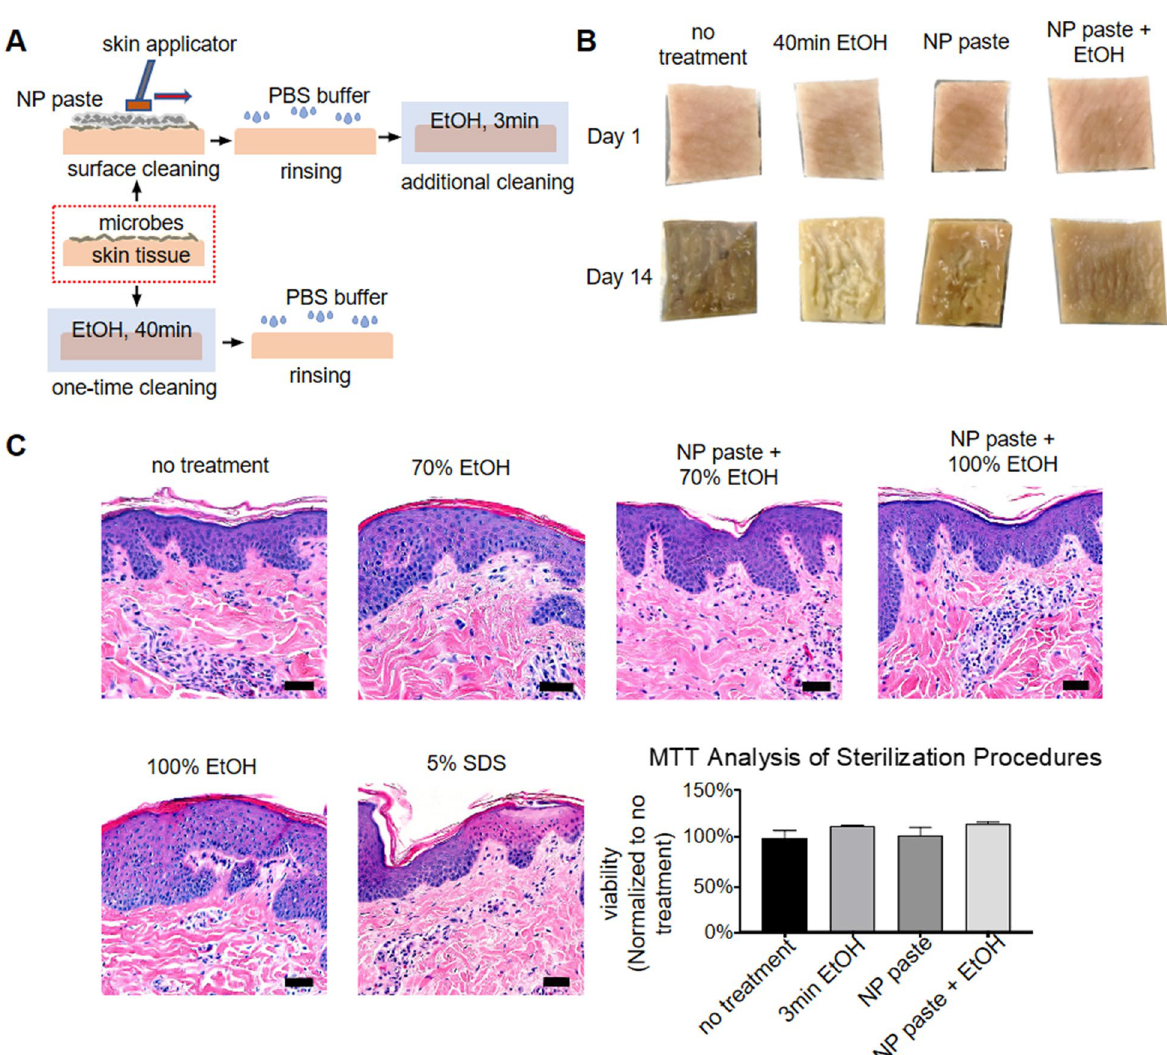
Figure 2. Porcine skin preparation process. ( A ) NP paste was applied to the skin surface and spread by moving an applicator gently back and forth for 5 min followed by sequential rinsing in PBS, 3 min incubation in 70% or 100% EtOH, and a final rinse in PBS. ( B ) Photographic images of skin at Day one and Day 14 after preparation. ( C ) Skin irritation analysis. Images: H&E stained micrographs (378×) for skin preparation compared with 40 min exposure to known irritants 5% SDS and 100% ethanol (Scale bar = 100 μm). Graph: MTT analysis of steps in skin preparation compared with no-treatment control. MTT analysis is graphed as mean ± SEM, and there were no statistically significant differences between groups (GraphPad